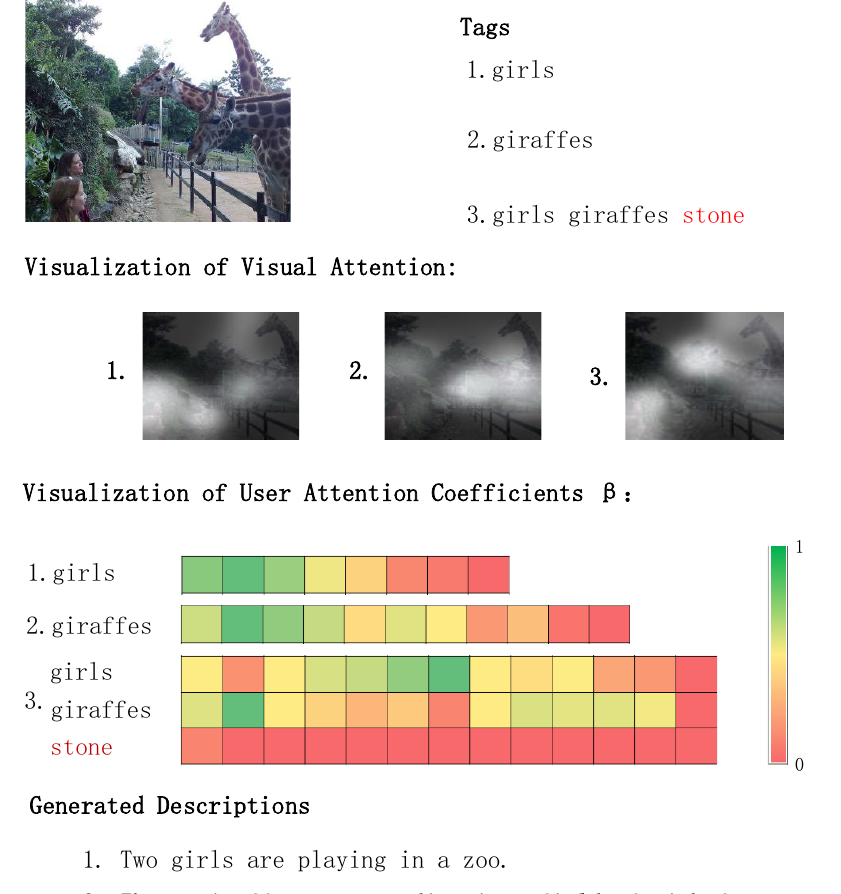
Figure 5. The visualization of visual attention and user attention weights β . The red word “stone” is the noise of the user tags. In the visualization of user attention, each grid represents the weight β of the tag when generating each word in the